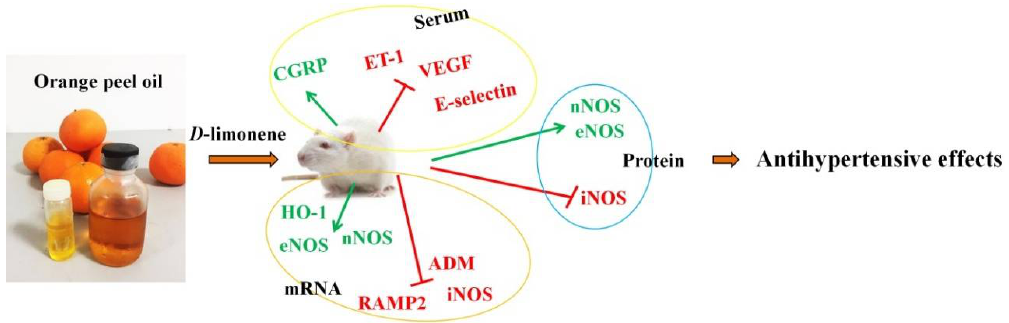
Figure 9. Mechanism of antihypertensive effects of orange peel oil. Notes: red symbol, inhibitory effect; green symbol, promoting effect. Orange peel oil contains an important core component of D -limonene. Orange peel oil could regulate blood pressure-related factors in serum, mRNA and protein expression of tissue for reducing blood pressure through D -limonene in hypertensive rats.